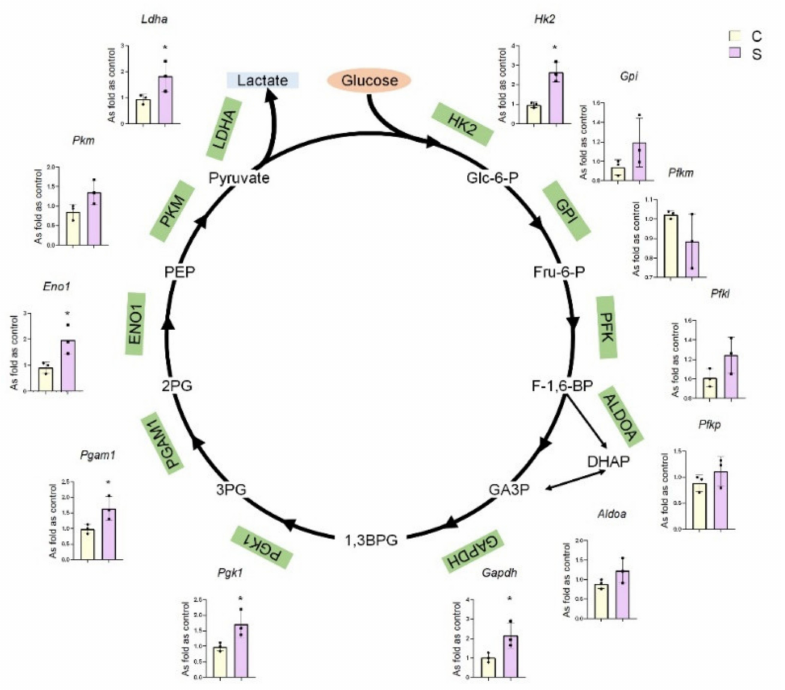
Figure 1. Differential mRNA expression profiles of key glycolytic enzymes in silicotic rat lungs. Hk2 /HK2: hexokinase2, Gpi /GPI: glucose-6-phosphate isomerase, Pfkm : phosphofructokinase